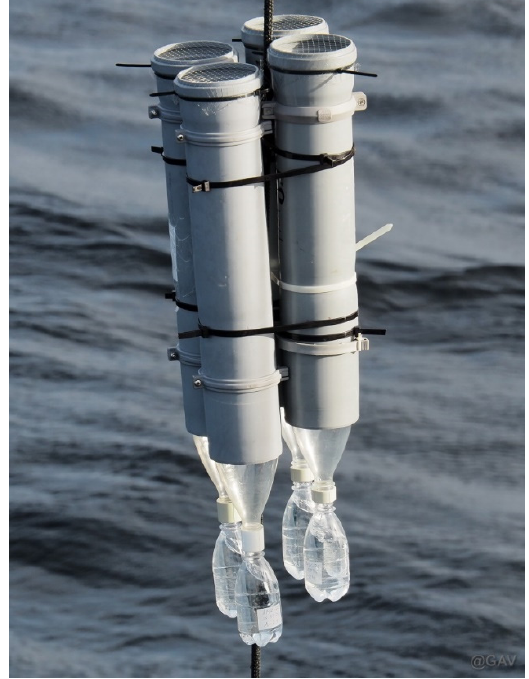
Figure 1. General view of the small sediment traps. Small sediment traps were installed at two to three horizons: surface, middle layer (under the thermocline) and near-bottom, at about 15 m above the bottom, in order to exclude the ingress of sediments stirred up during the landing of the anchor to the bottom. The exposure lasts for several days.